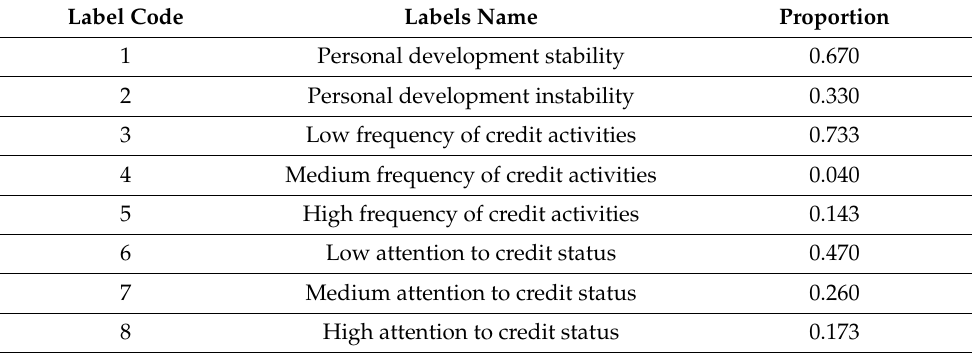
Table 9. Proportion of one label.